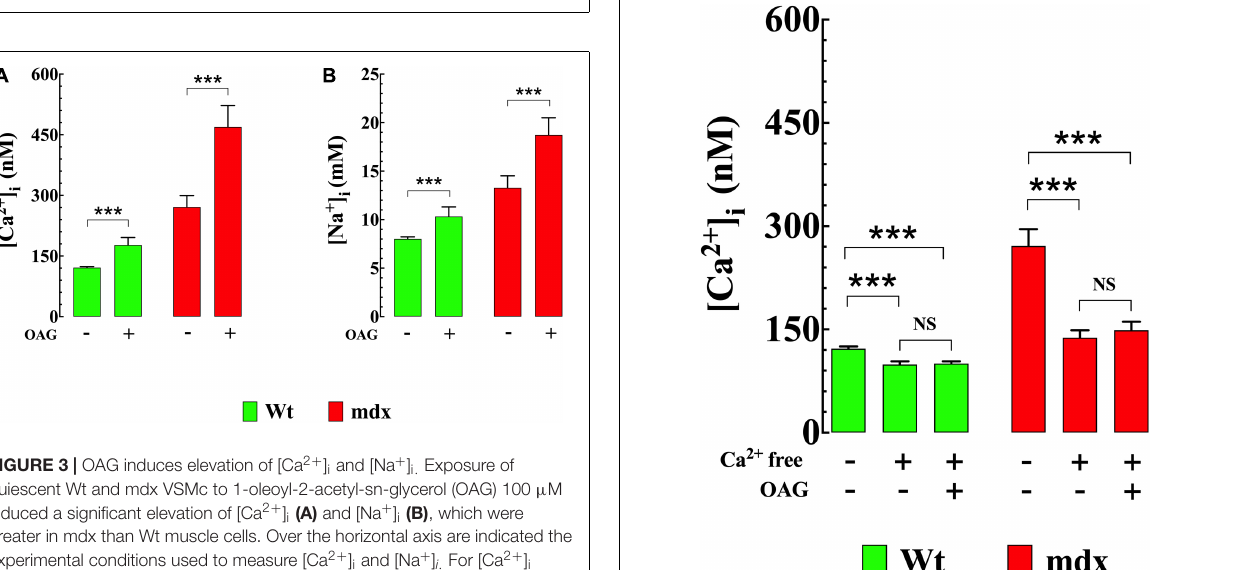
FIGURE 2 | Simultaneous measurements of Vm and [Ca 2 + ] i in single smooth muscle cells from control Wt and mdx mice. Effects of OAG. Vm is the membrane potential recorded with a conventional microelectrode filled with 3 M KCI, and V Cae is the potential recorded with the calcium-selective electrode after the subtraction of Vm. V Cae potential represents cell intracellular [Ca 2 + ]. In Wt, [Ca 2 + ] i was 124 nM, and the Vm was –62 mV before OAG treatment and represents the cell intracellular [Ca 2 + ] (A) . After incubation in OAG 100 µ M [Ca 2 + ] i increased to 187 nM with no effect on Vm (–63 mV) (B) . The measurements of Vm and [Ca 2 + ] i before and after OAG treatment were carried in the same muscle cell. In the mdx muscle cell Vm: was –62 mV and [Ca 2 + ] i was 258 nM before OAG (C) and after OAG incubation, [Ca 2 + ] i rose to 492 nM after OAG, with no change in Vm (–65 mV) (D) . The determinations of Vm and [Ca 2 + ] i before and after OAG treatment were carried in two distinct muscle cells.